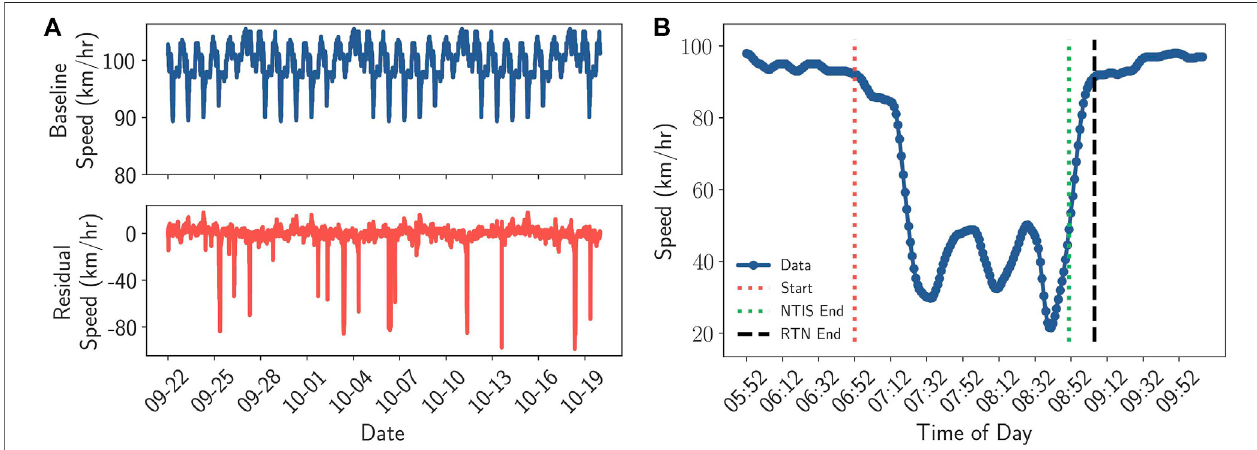
FIGURE2| Thebaselineforasinglelinkandanexampleincident.Thebaselinecapturesclearseasonalityinthedata.Onamuchshortertime-scale,weseeadrop in speed in thewake ofanNTIS incident fl ag,and arecoveryafter asustained period oflow speed. (A) : An example weeklybaseline,and residuals (data — baseline) fora singlelink,showing4weeksofdata. (B) AnexamplecomparisonbetweenNTISendtimesandtheReturntoNormal(RTN)endtime.Wearetryingtopredictthetimeuntil we return to normal operating conditions, rather than the time at which the NTIS fl ag is turned off.